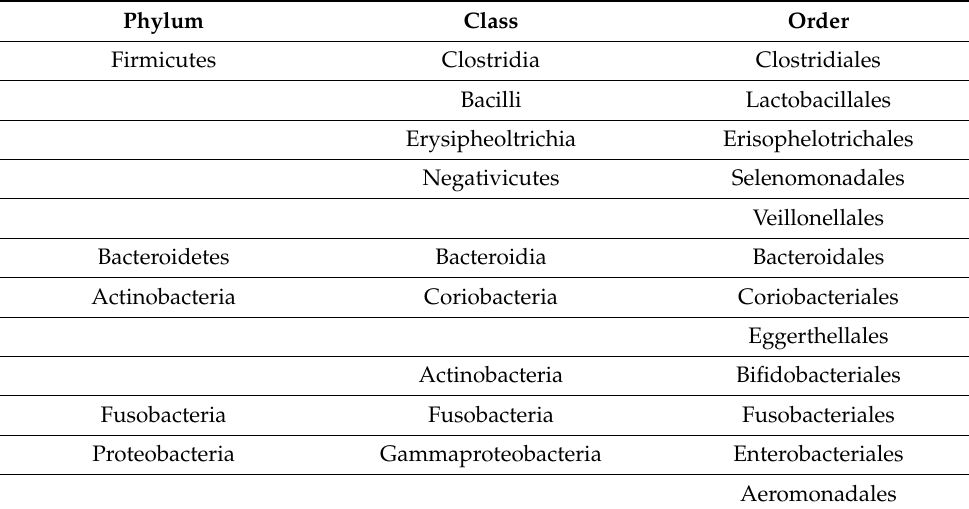
Table 1. Taxonomic data of most common gut microbial populations